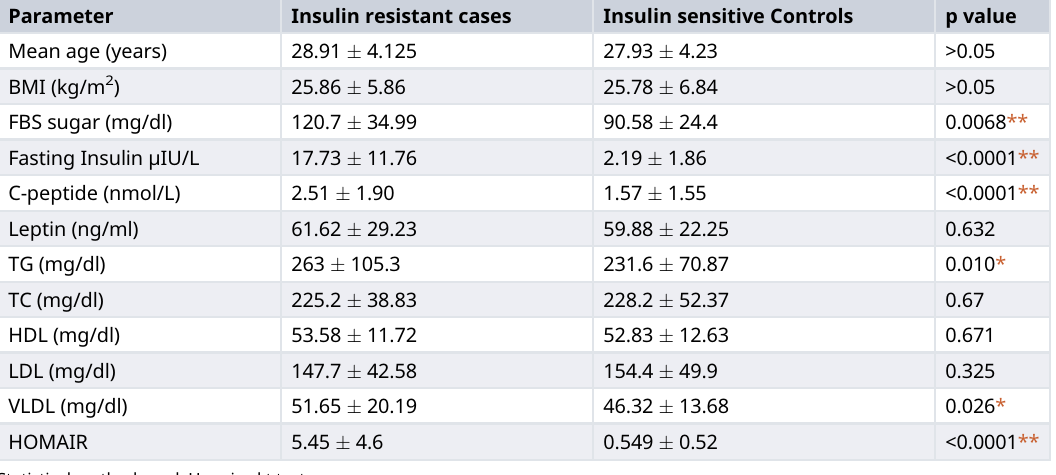
Table 4. Demographic and biochemical parameters in insulin resistant and insulin sensitive women. Parameter